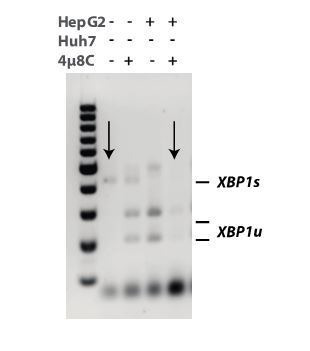
Visible bands in lane 2 and 4, which corresponds to LX2-monocultures and LX2+Hep2 co-cultures treated with 4u8C.